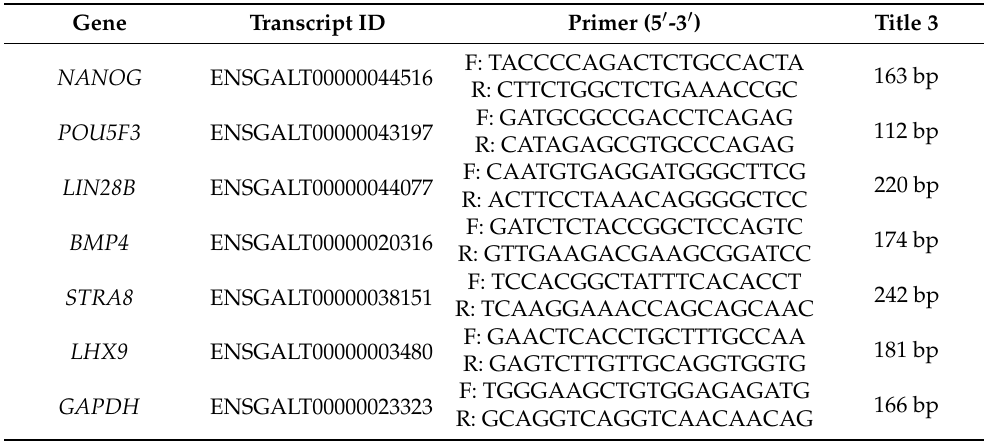
Table 1. Sequences of qRT-PCR